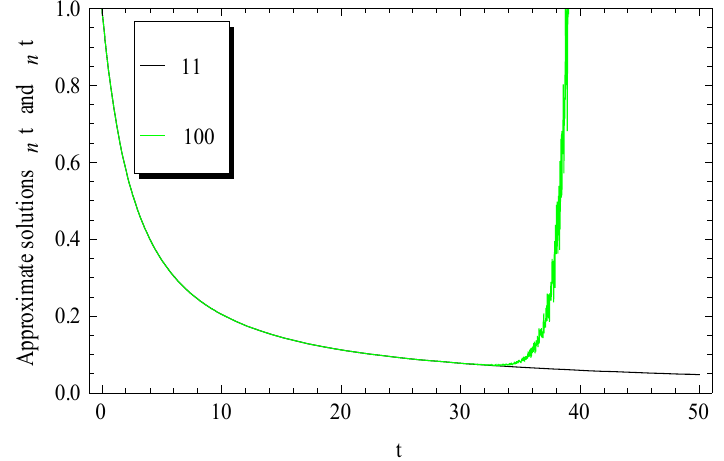
Figure 4. Comparison between the Adomian approximate solutions and power series solution at λ = 1 and q = 1.5.